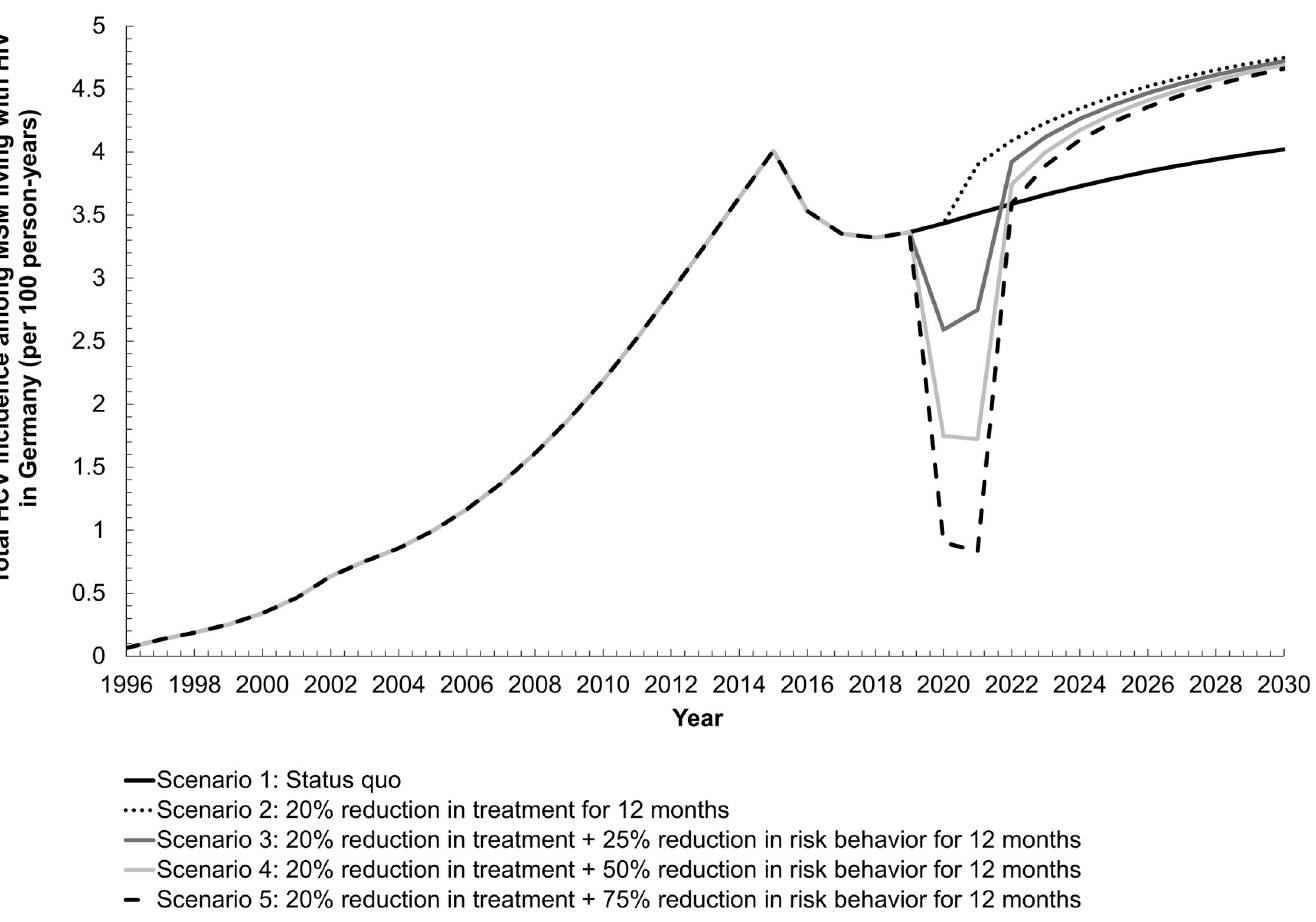
Fig 4. Modeled disruptions in hepatitis C virus (HCV) screening, treatment, and various reductions in risk behavior to epidemic trajectories of total HCV incidence among men who have sex with men living with diagnosed HIV in Germany.